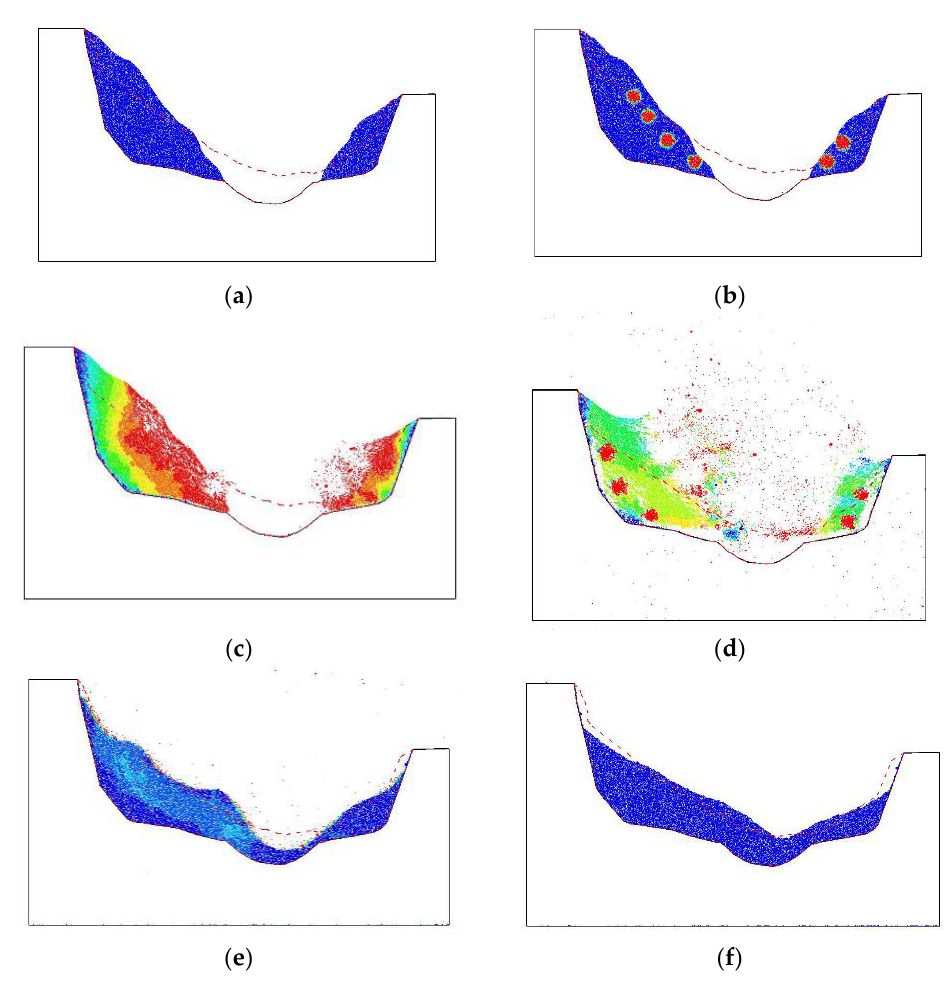
Figure 3. Typical process of discrete element simulation of directional blasting: ( a ) 0.000 s; ( b ) 0.003 s; ( c ) 0.200 s; ( d ) 2.090 s; ( e ) 50.000 s; ( f ) 51.2 s.